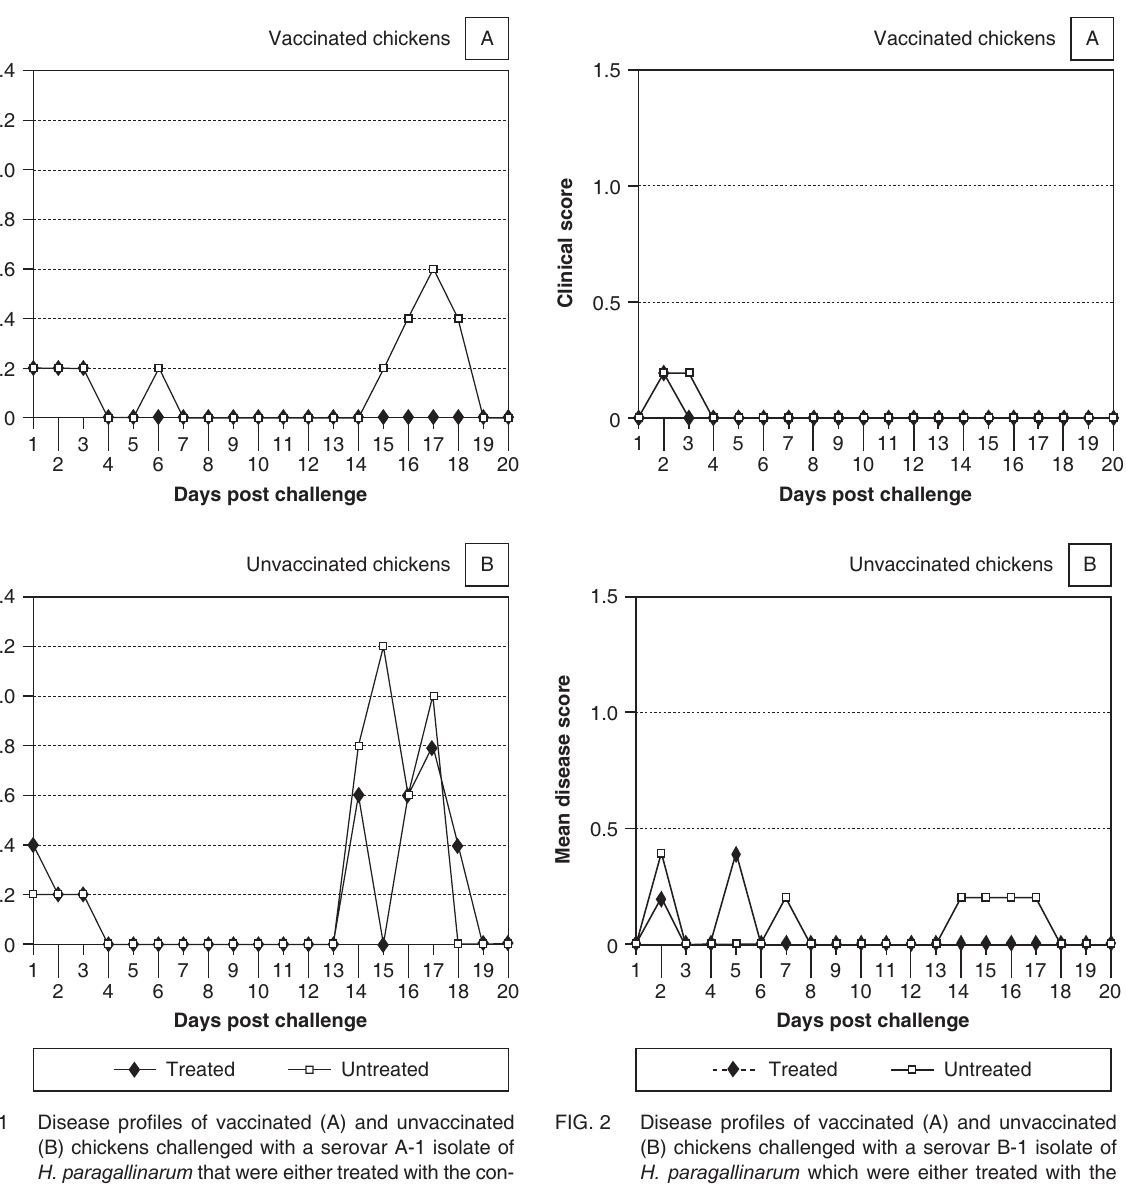
FIG. 2 Disease profiles of vaccinated (A) and unvaccinated (B) chickens challenged with a serovar B-1 isolate of H. paragallinarum which were either treated with